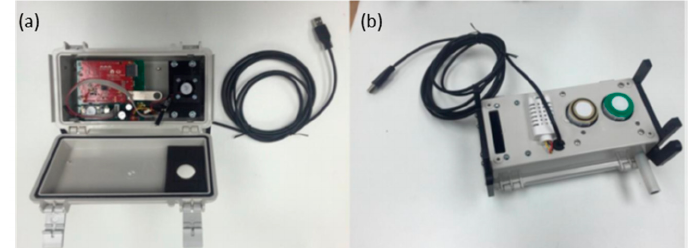
Figure 1. A block diagram of the sensor and microprocessor